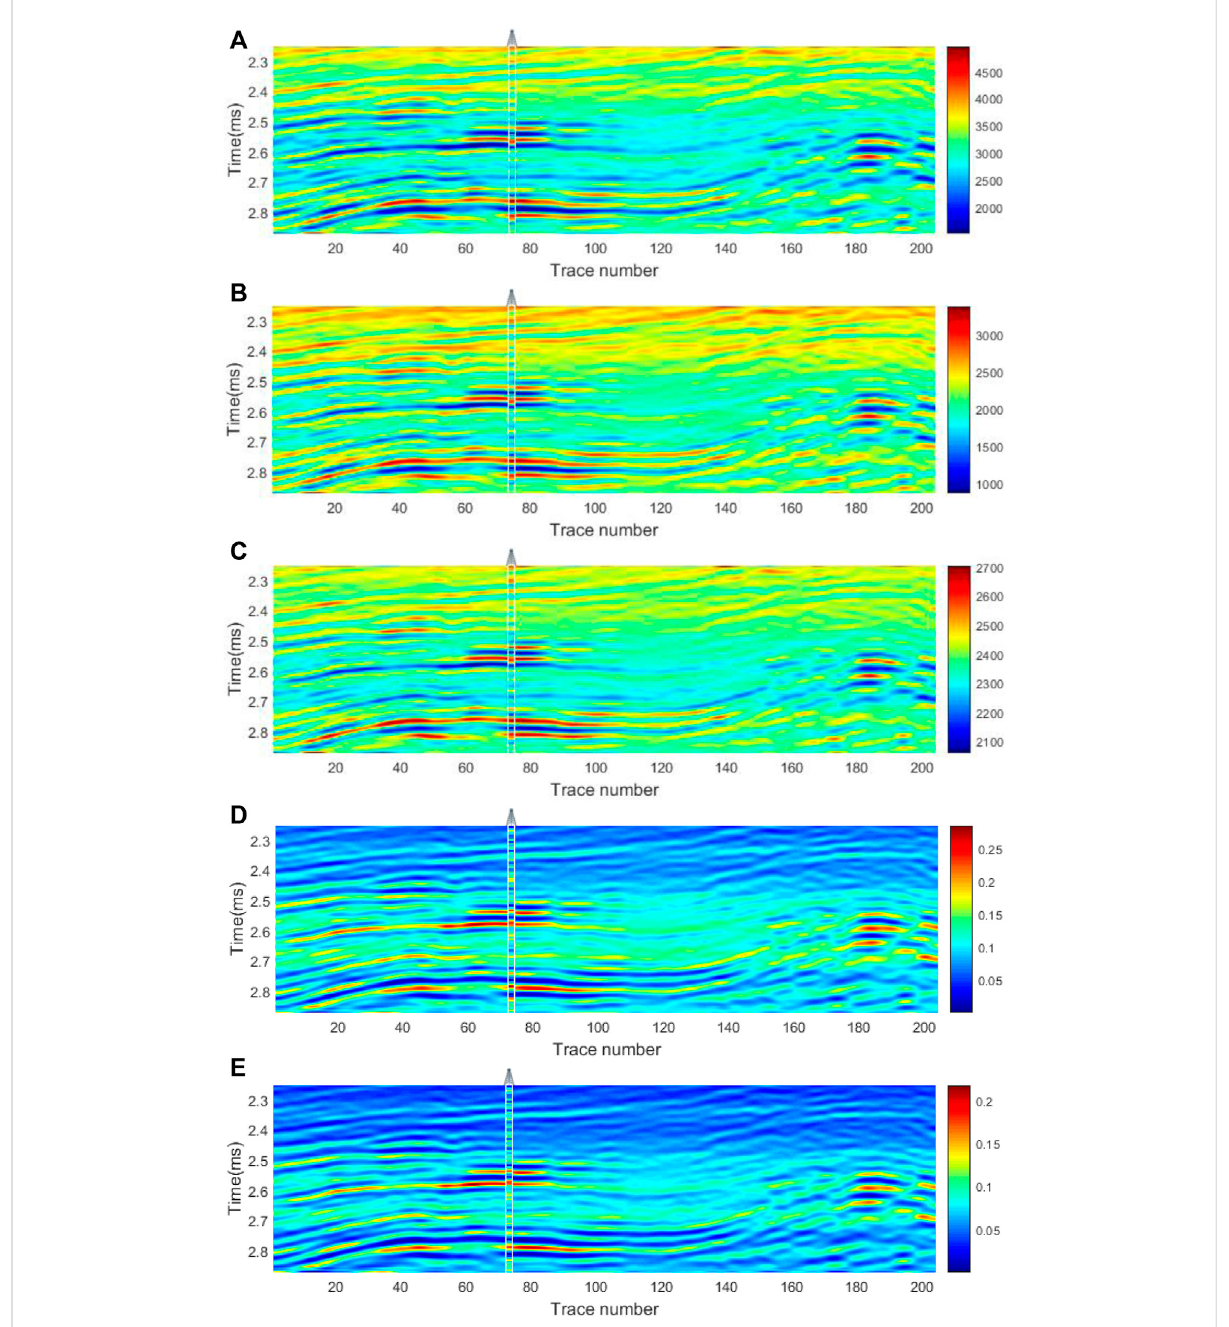
FIGURE 9 Inverted results of exact equation at the well location: (A) P-wave velocity (m/s); (B) S-wave velocity (m/s); (C) density (kg/m 3 ); (D) ε ; (E) δ